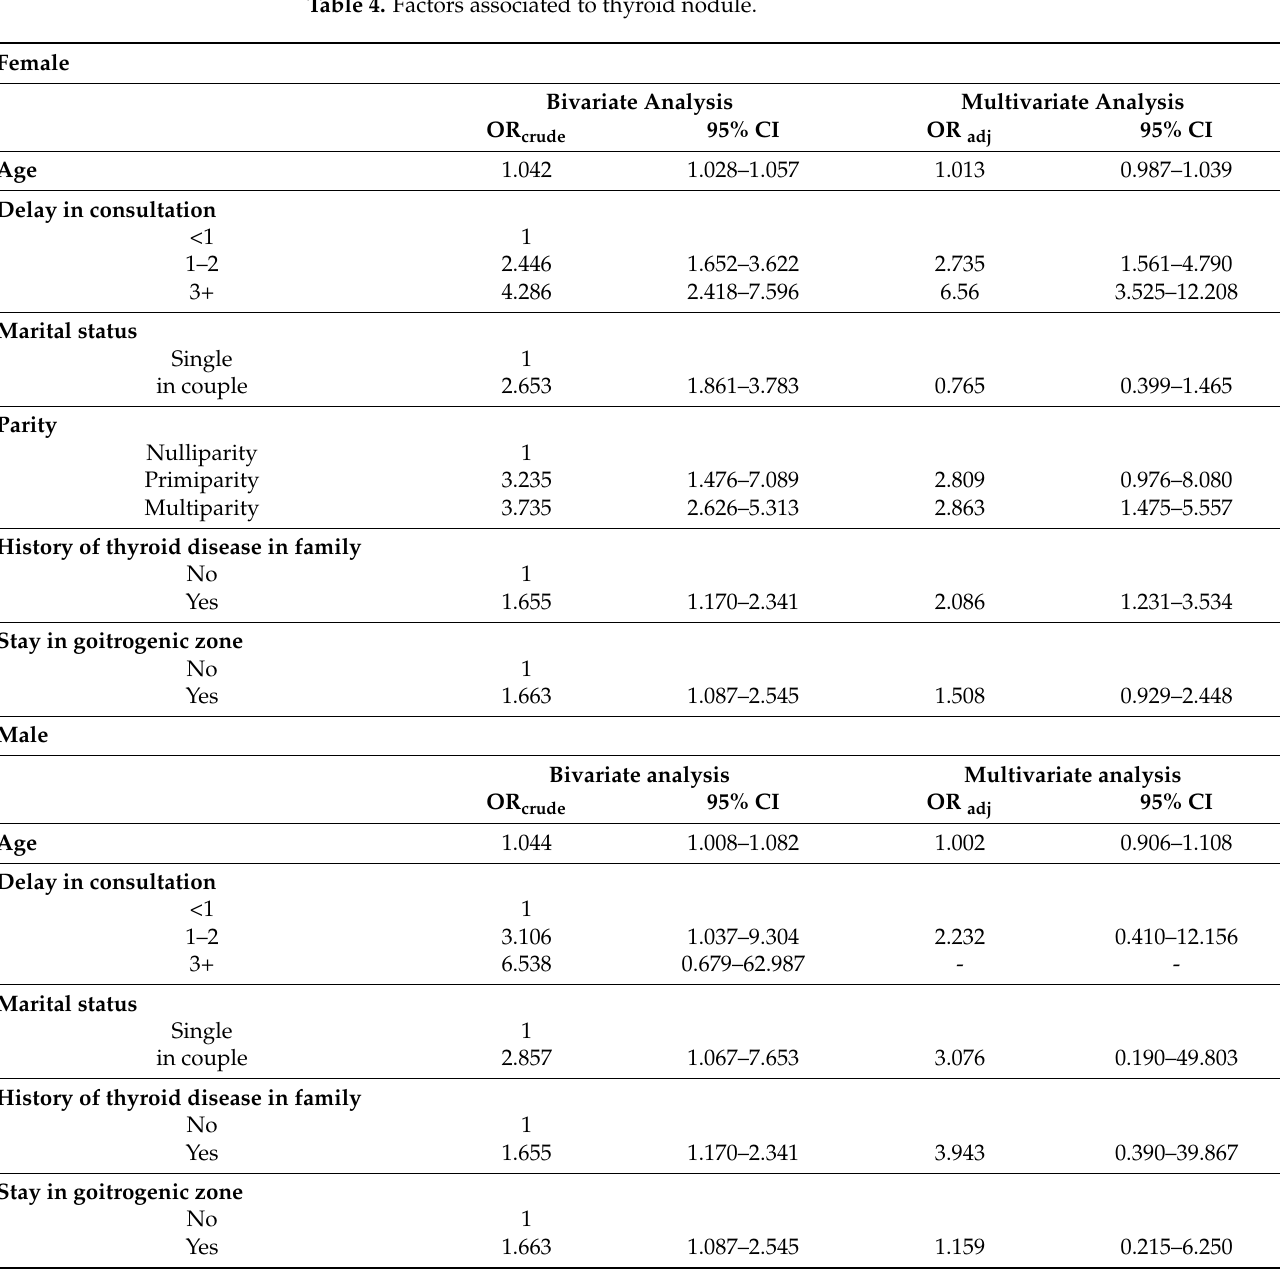
Table 4. Factors associated to thyroid